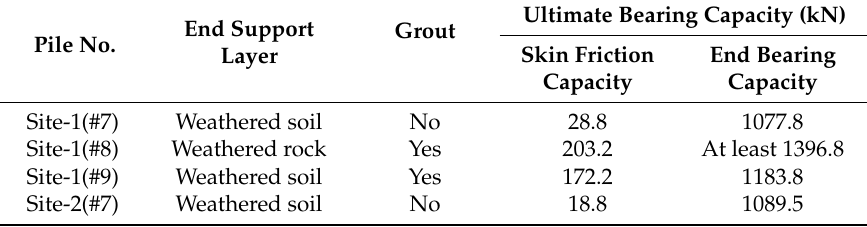
Table 6. Classification of skin friction and end bearing capacity with load test